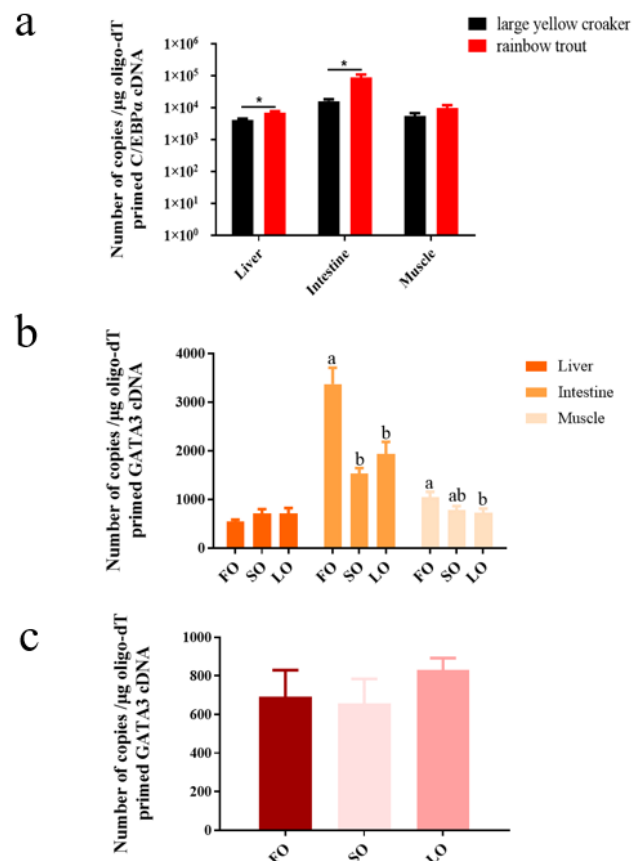
Figure 5. The absolute expression of C/EBP α and GATA3 in tissues of large yellow croaker and rainbow trout. The absolute expression of C/EBP α gene in liver, intestine, and muscle of large yellow croaker and rainbow trout ( a ). The absolute expression of GATA3 gene in liver, intestine, and muscle of large yellow croaker ( b ) and liver of rainbow trout ( c ). Values are presented as mean ± SEM ( n = 3). The “*” means a significant difference ( p < 0.05). Bars without sharing a common letter are significantly different ( p < 0.05). FO: 100% fish oil as a lipid source in the diet. LO: 100% linseed oil as a lipid source in the diet. SO: 100% soybean oil as a lipid source in the diet.